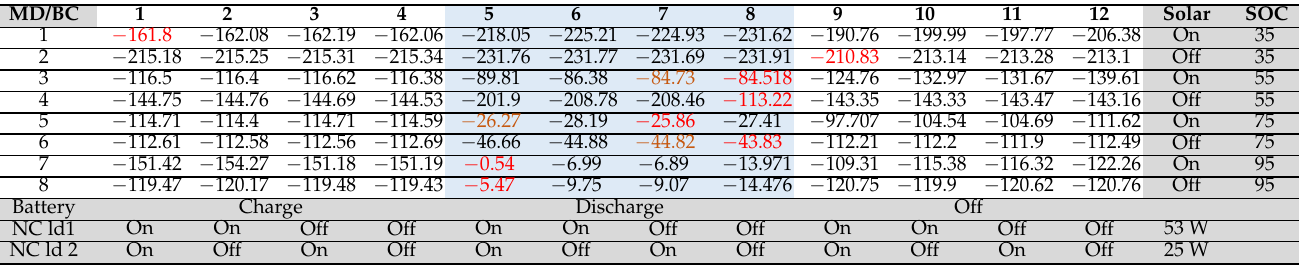
Table A1. Q-table for reliability analysis in islanded